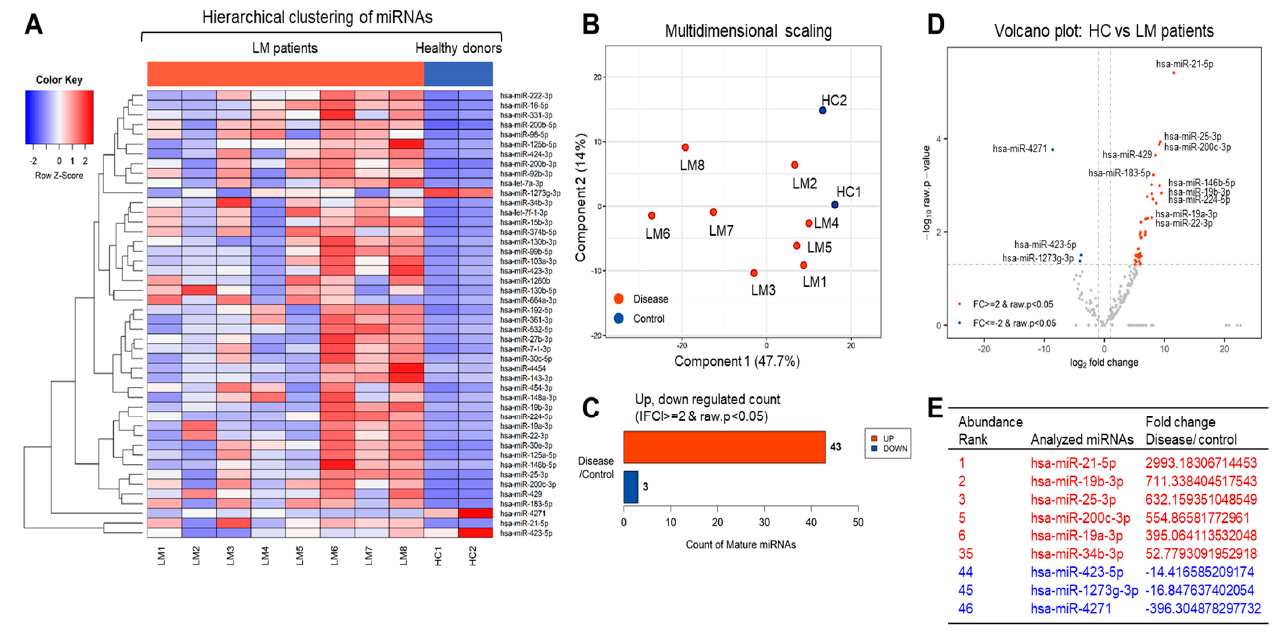
Figure 3. Distinct expression of miRNAs in EVs from LM patient CSF. Analysis of relative miRNA expression profile in EVs extracted from CSF of LMs and HCs. Hierarchical clustering analysis of significantly expressed miRNA was visualized via ( A ) heatmap showing z score of extravesicular miRNA from HC ( n = 2) and patients with LM ( n = 8) with 43 upregulated (red) and 3 downregulated (blue) miRNAs. ( B ) Multidimensional scaling (MDS) map of HC and LM was generated with proximity (calculated in Euclidean distance) indicating similarity, and ( C ) count of up- and downregulated mature miRNAs were found by fold change and p- value. ( D ) Volcano plot shows differentially expressed miRNA in HC and LM patients with the x-axis showing log2 fold-change and y-axis showing − log10 of the p -value from LM versus HC miRNA expression counts. ( E ) Table displays the fold change of 6 upregulated and 3 downregulated miRNAs in LM compared to HC ranked in the order of abundance.